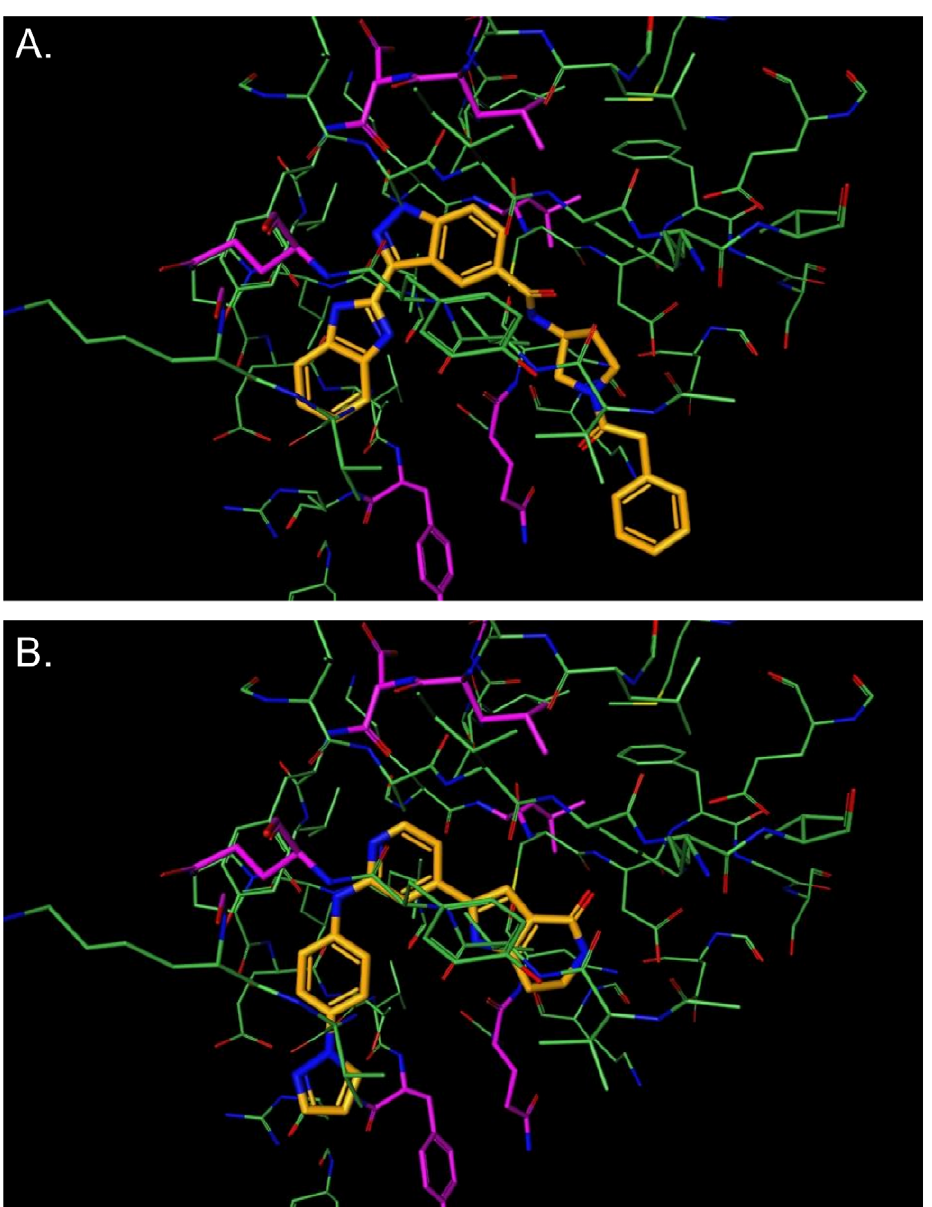
Figure 4. Modelling of the binding-site residues with putative inhibitors. Compounds (orange) docked into the catalytic domain of the crystal structure of Hs GSK3 beta in their binding modes. A: CE-317112 shows preference for Hs GSK-3 beta. B: PF-4903528 shows preference for Tbru GSK-3 short. The residues that differ between human and Tbru GSK-3 short are shown in magenta, with only L132M (top centre of the image) directly lining the pocket. Images were created using the Pfizer molecule-modelling package